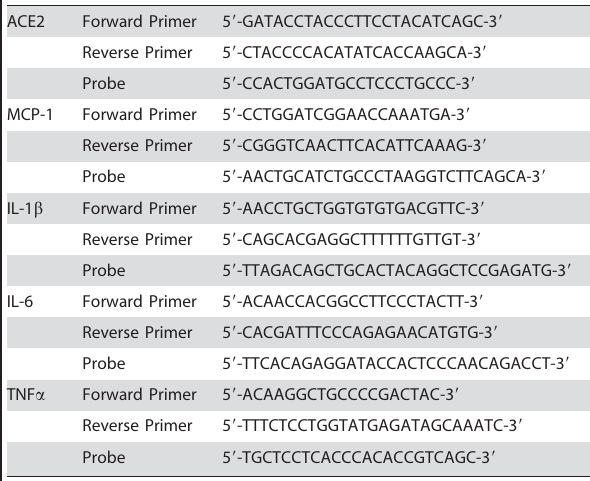
Table 1. Primers and probes sequences for TaqMan real-time PCR